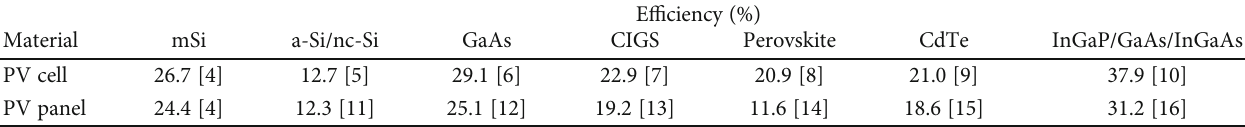
Table 1: E ffi ciency of the PV cells and panels measured under STC